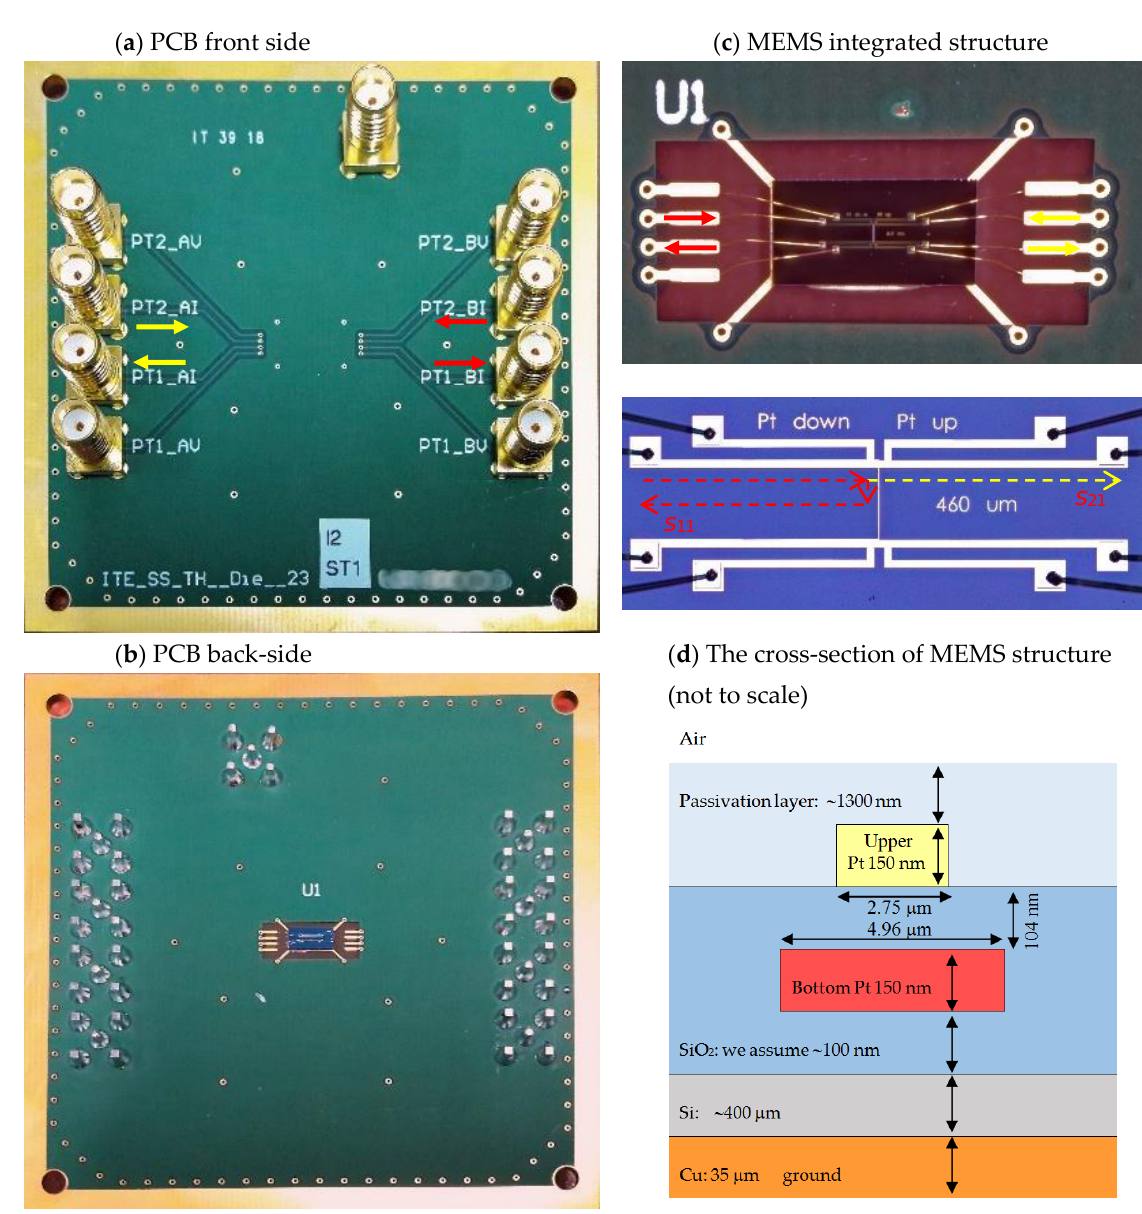
Figure 1. The micro-electro-mechanical systems (MEMS) test structure ( c ) is bonded to the test boards ( a , b ). The simplified cross-section of the MEMS structure is presented in ( d ). PCB, printed circuit board.